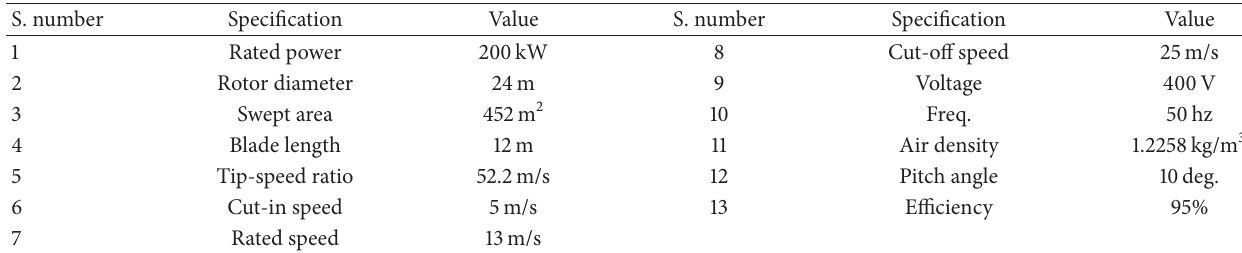
Table 5: Specification of MICON M450-200 wind turbine.